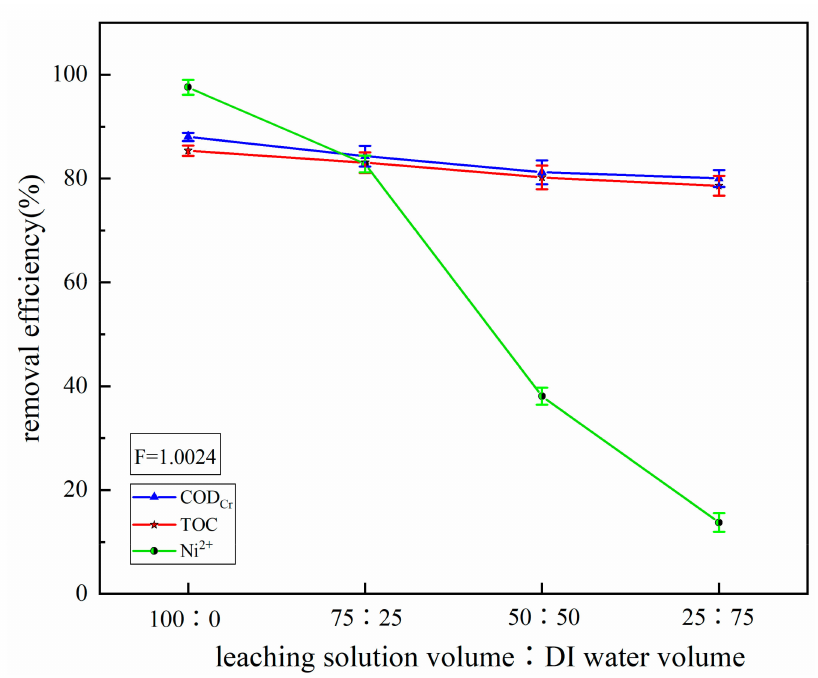
Figure 4. Relationship between the removal efficiency of COD Cr , TOC, and Ni 2+ and dilution ratio. Electrolysis conditions: solution 180 mL, current density 50 A/m 2 , temperature 25 ◦ C, and pH 3.